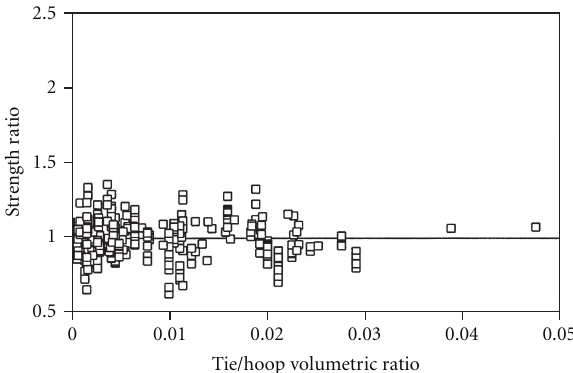
Figure 10: E ff ect of end eccentricity ratio e /h on FEM strength ratios for composite columns ( n =